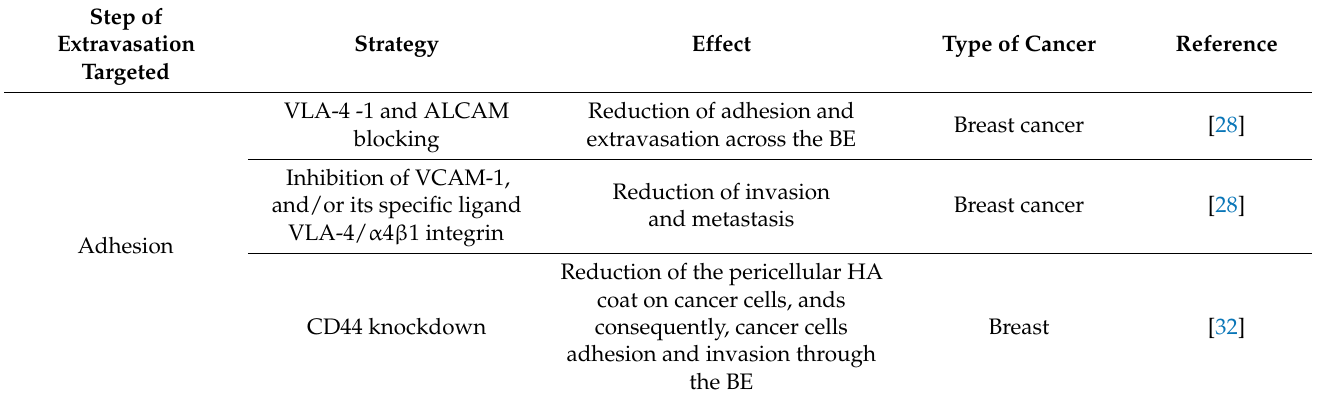
Table 6. Potential pre-clinical therapeutic strategies targeting the extravasation step to suppress